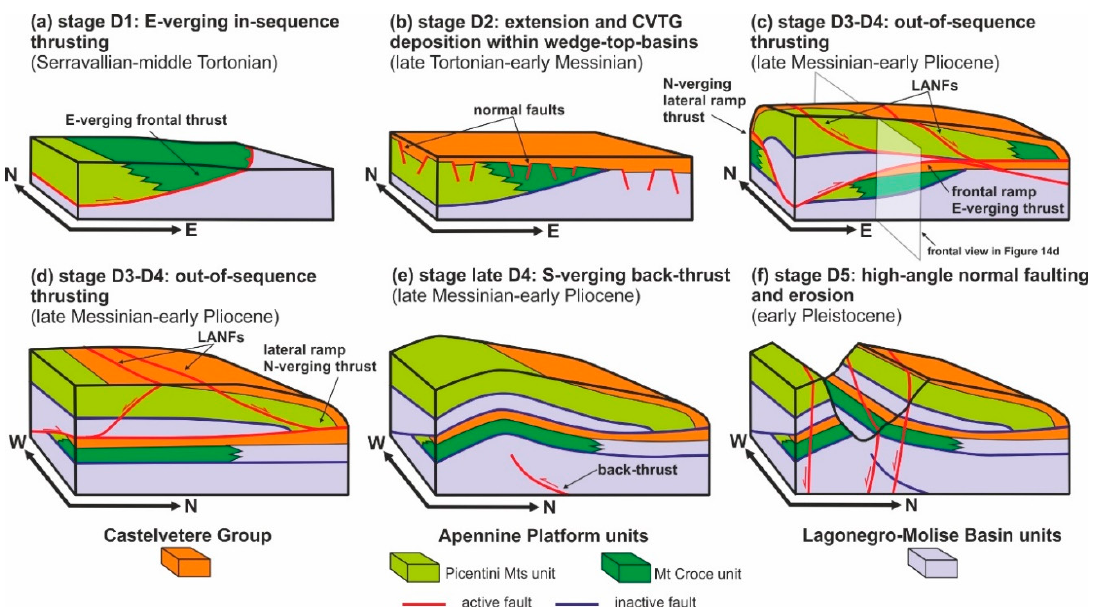
Figure14. ( a – f )Imageshowingthetectono-stratigraphicevolutionfromSerravalliantoEarlyPleistocene Figure 14. ( a – f ) Image showing the tectono-stratigraphic evolution from Serravallian to Early of the Campagna and Gi ff oni tectonic Pleistocene of the Campagna and Giffoni tectonic windows.